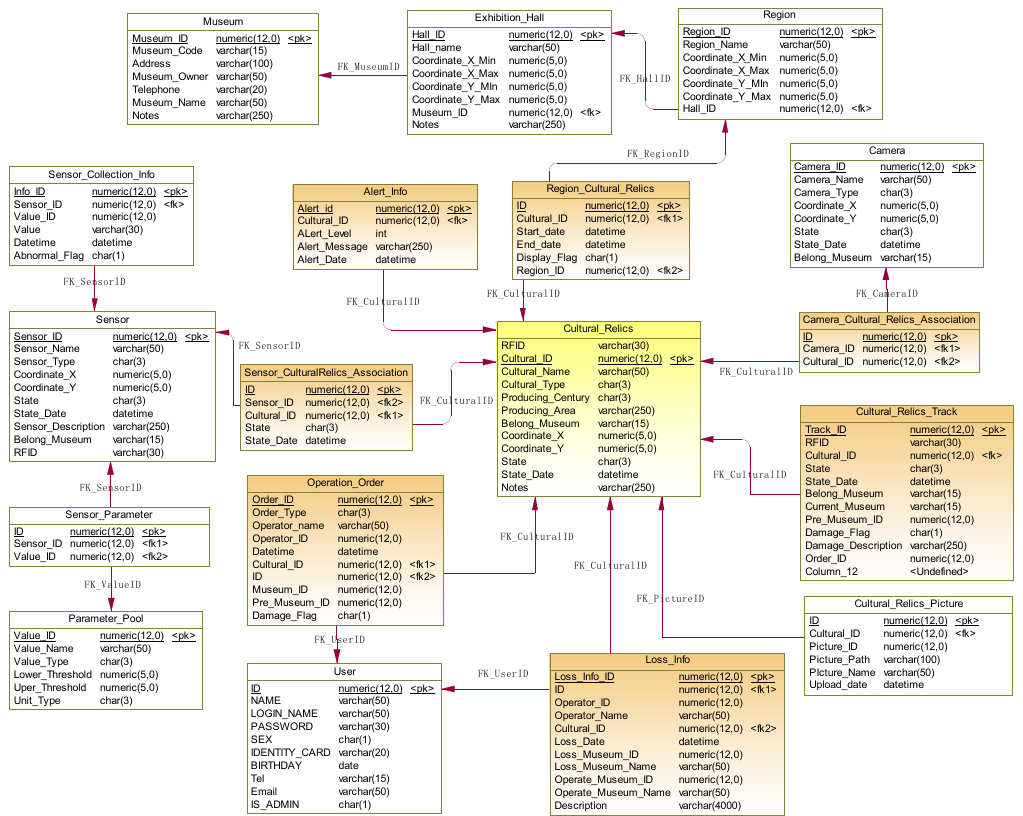
Figure 3. Logical data model of the proposed system.